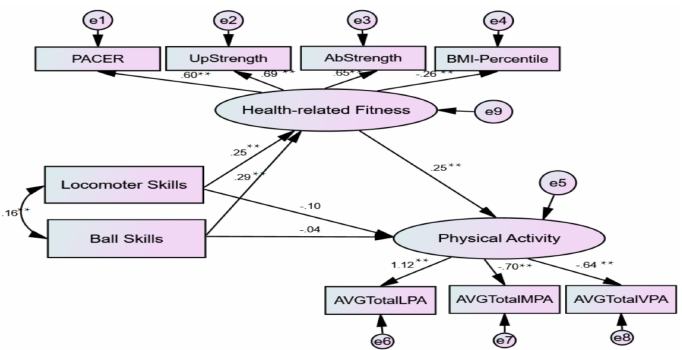
Figure 1. The Structural Model with Standardized Path Coefficients Model-1: FMS»HRF»PA. PACER = Progressive Aerobic Cardiovascular Endurance Run; PA = physical activity; BMI = body mass index. * p < 0.05; ** p <